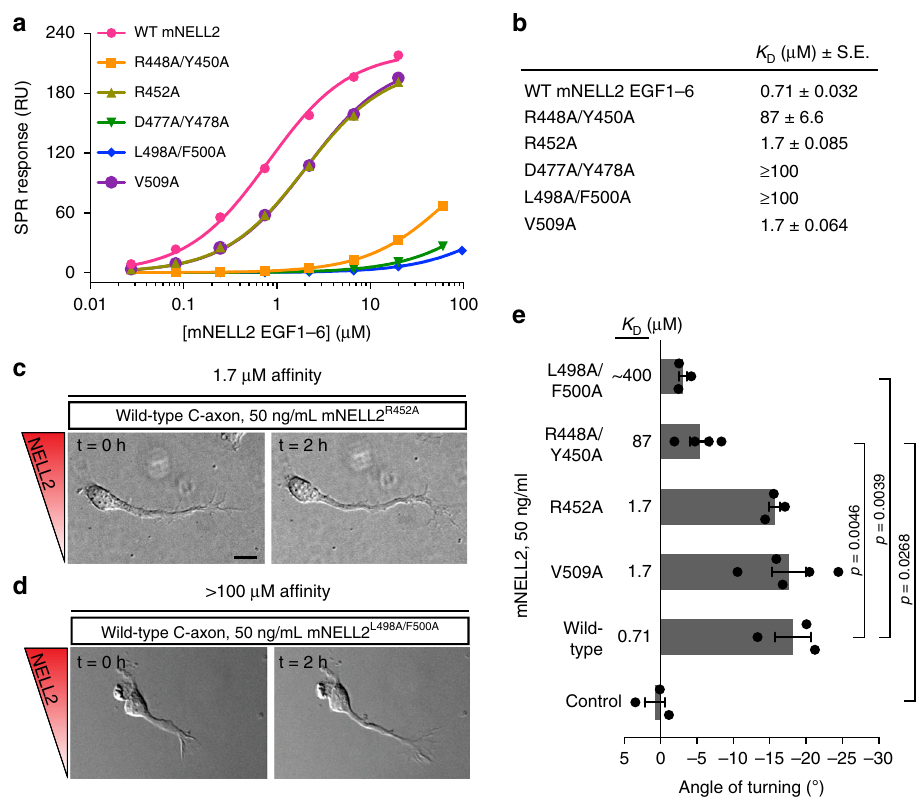
Fig. 4 Axon repulsive activity of NELL2 correlates with its af fi nity towards Robo3. a , b Binding isotherms ( a ) for SPR experiments testing the interaction of mRobo3 FN1 – 3 with mNELL2 EGF1 – 6 WT and mutants. Original sensorgrams are in Supplementary Fig. 3d. SPR responses are fi t with 1:1 Langmuir isotherm model to calculate dissociation constants ( K D ) ( b ). The ± errors represent standard error of the fi t. DIC images of commissural axons exposed to mutant forms of NELL2 with Robo3-binding af fi nities of 1.7 µ M ( c ) and ≥ 100 µ M ( d ) (0 and 2 h). Commissural axons respond to NELL2 mutants with 1.7 µ M binding af fi nity, but not with ≥ 100 μ M af fi nity. ( e ) Quanti fi cation of commissural axon turning angles in response to wild-type NELL2 or NELL2 containing point mutations ( n = 3 for WT NELL2, R452A, and L498A/F500A; n = 4 for R448A/Y450A; n = 5 for V509A). K D values are dissociation constants measured for mNELL2 mutants via SPR ( b ). Scale bar, 10 µ m ( c , d ). b